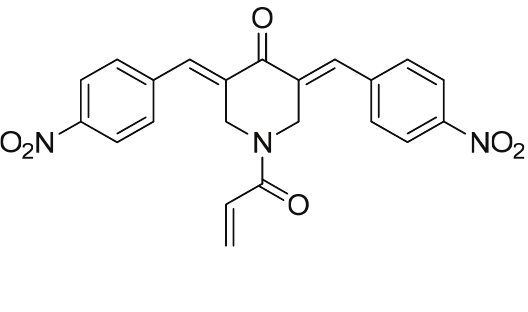
Figure 4. Chemical structure of